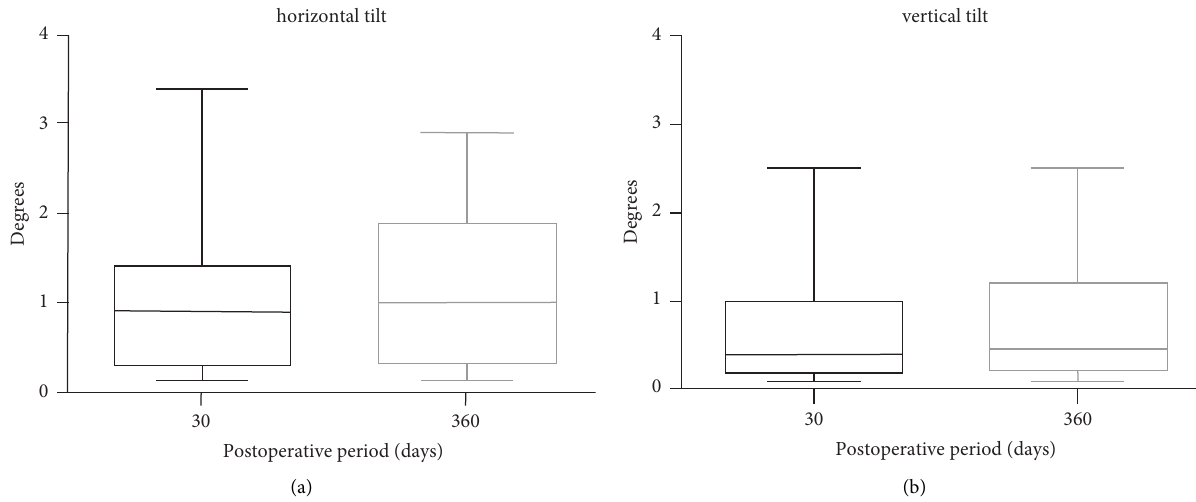
Figure 5: Box plot showing the stability of horizontal (a) and vertical (b) tilt of FILSSF IOL at 1 and 12 months after